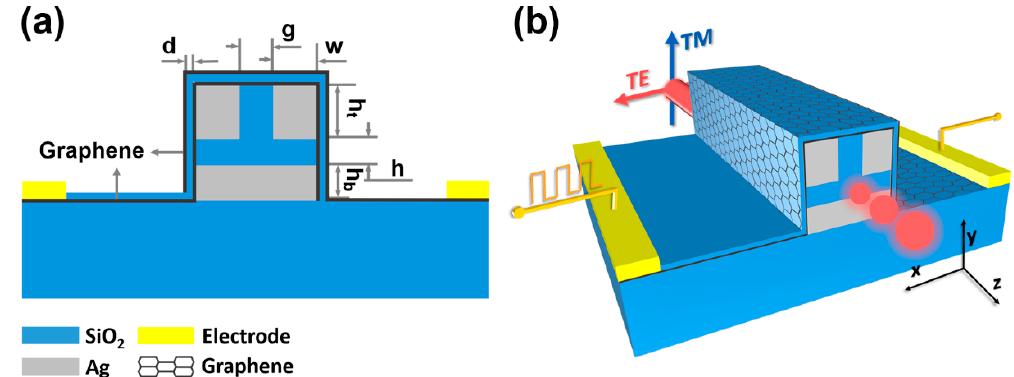
Figure 1. (a) Two-dimensional (2D) cross section; (b) three-dimensional (3D) view of the graphene modulator with dual Figure 1. ( a ) Two-dimensional (2D) cross section; ( b ) three-dimensional (3D) view of the graphene modulator with dual built-in orthogonal slots waveguide. built-in orthogonal slots